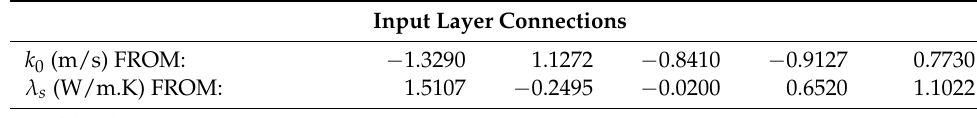
Table 5. The neural − network connection for the ANN